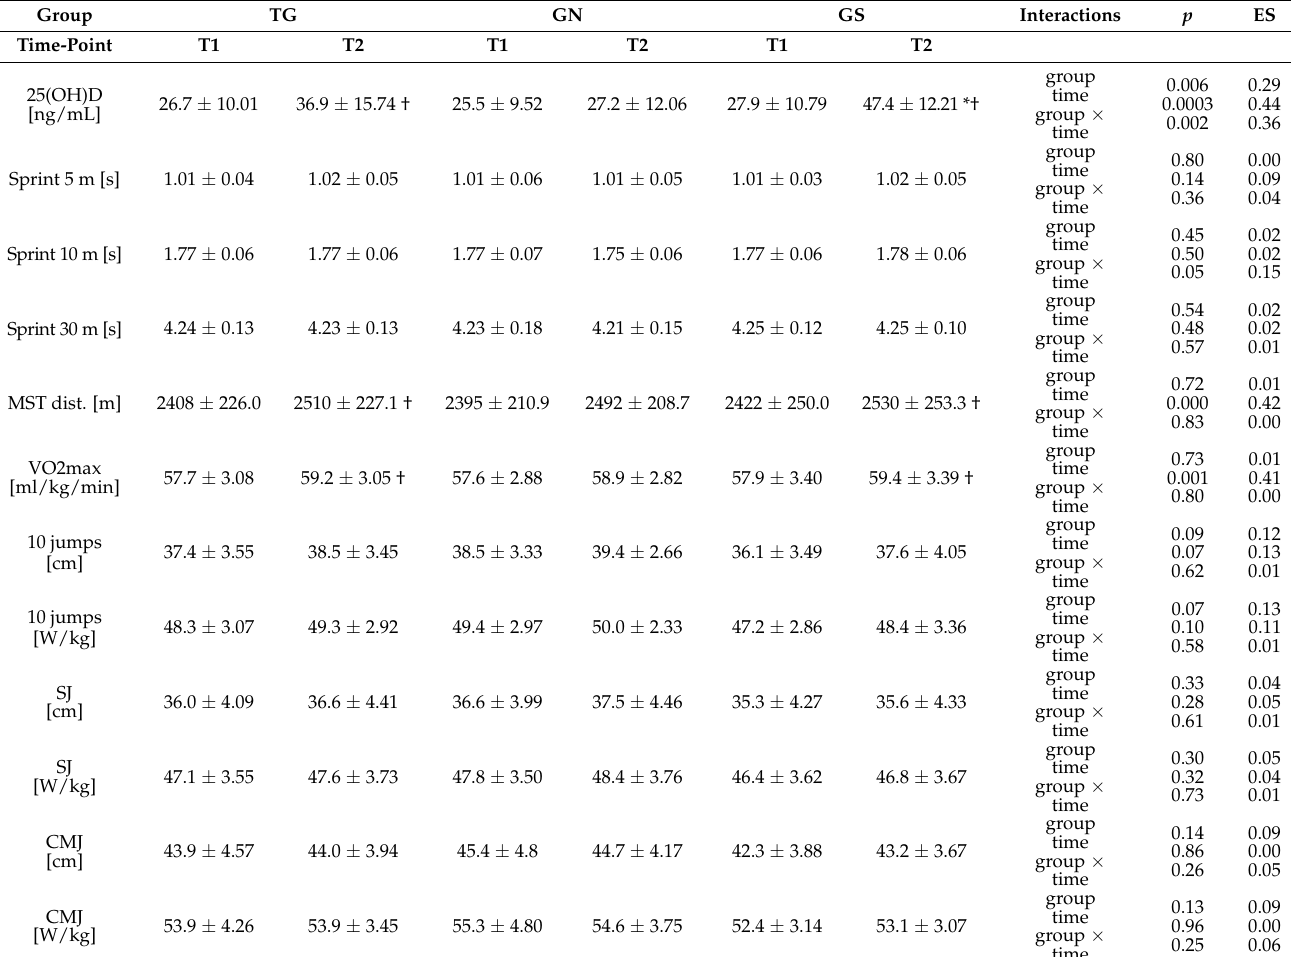
Table 2. The 25(OH)D concentrations and the physical fitness values in the tested athletes: total group (TG), the group supplemented with vitamin D (GS), and the non-supplemented group (GN) at baseline (T1) and after 8 weeks